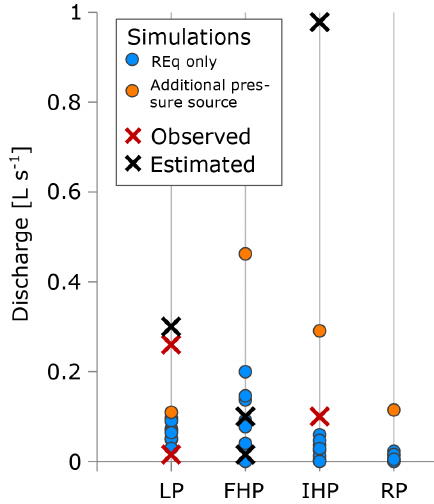
Figure 9. Simulated, observed (measured) and estimated (“by eye”) spring discharge rates. Blue dots are discharge rates simulated for groundwater model scenarios for which the source term is defined by the rate of basal permafrost aggradation (Figs. 7 and 8). The orange dots are discharge rates simulated for a groundwater model scenario with an additional unknown pressure source (Fig.